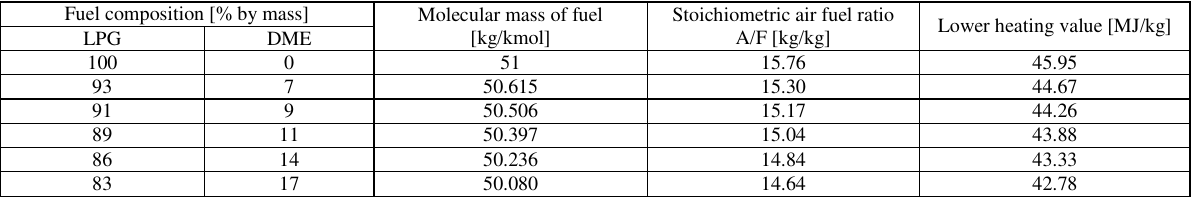
Table 2. The parameters of fuels prepared for